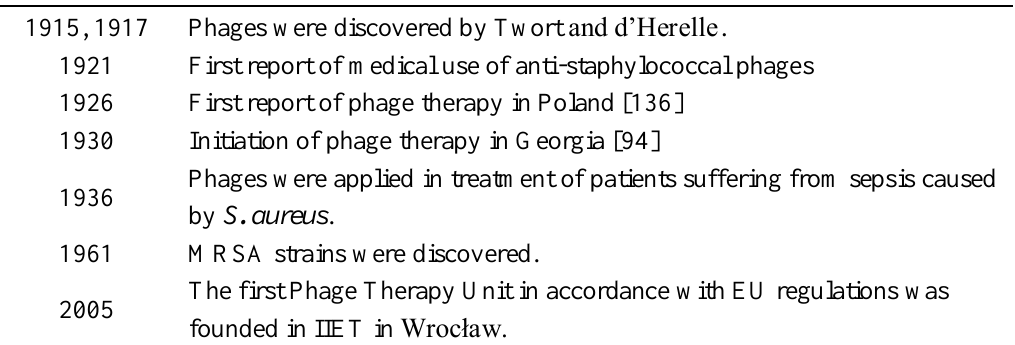
Table 1. Milestones in the history of applications of